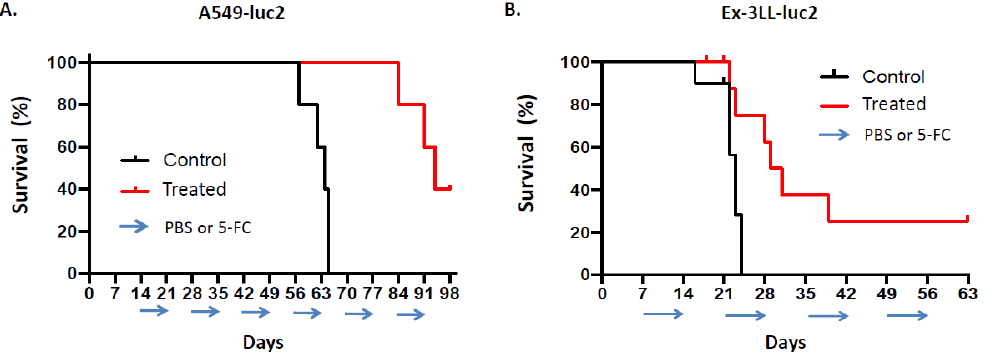
Figure 8. Bioluminescence imaging of Toca 511/5-FC prodrug activator gene therapy in orthotopic pleural dissemination models of lung cancer. Luciferase-marked human A549-luc2 ( A ) or murine Ex-3LL-luc2 ( B ) tumors were established by intrathoracic injection and Toca 511 infection as de- scribed in Methods, and IVIS optical imaging was performed at serial time points ( n = 5 per group). ( A ) In the A549-luc2 model, 7-day cycles of 5-FC (500 mg/kg, red line) or PBS (black line) were ad- ministered every other week (arrows) from day 14 post-tumor establishment; * p = 0.0147. ( B ) In the Ex-3LL-luc2 model, 7-day cycles of 5-FC (500 mg/kg, red line) or PBS (black line) were administered every other week starting from day 7; ** p = 0.0326. Lower panels show representative serial imaging results from an individual animal in each treatment group for each model.